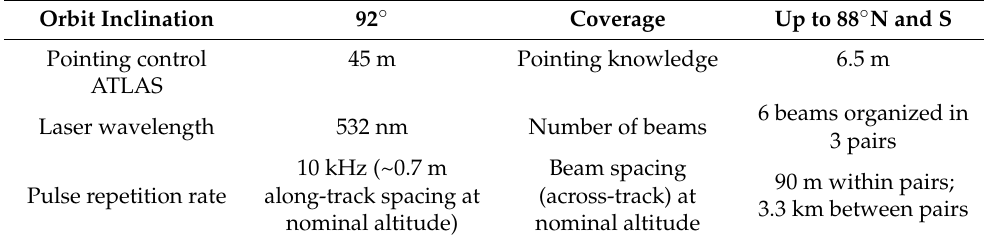
Table 1. The introduction of information on ICESat-2 mission parameters Reprinted with permission from Ref [41]. 2019, Neumann et